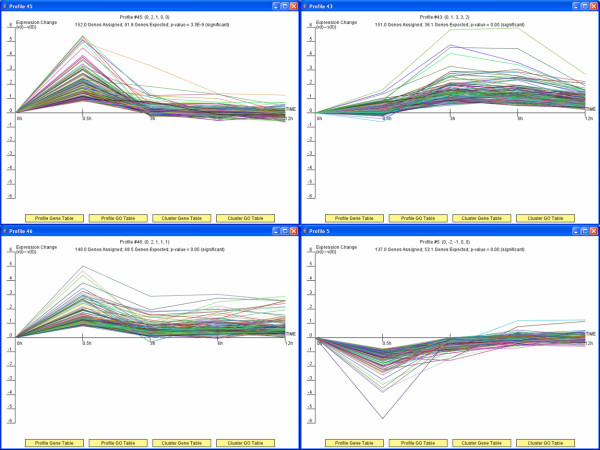
Four model profile detailed information windows. The above image are screenshots of four detailed model profile windows for the data of Figure 3. The four profiles shown were those which had the most genes assigned. All four profiles were significant, and the two profiles on the left were clustered together. Along the top of each window are statistics on the number of genes assigned to the profile, the number of genes expected, and the enrichment p-value. Along the bottom of the window is a button to display a table of genes assigned to the profile and a button to display a GO enrichment table for the profile (Figure 6). Additional buttons can be used to extract the cluster information for this profile.